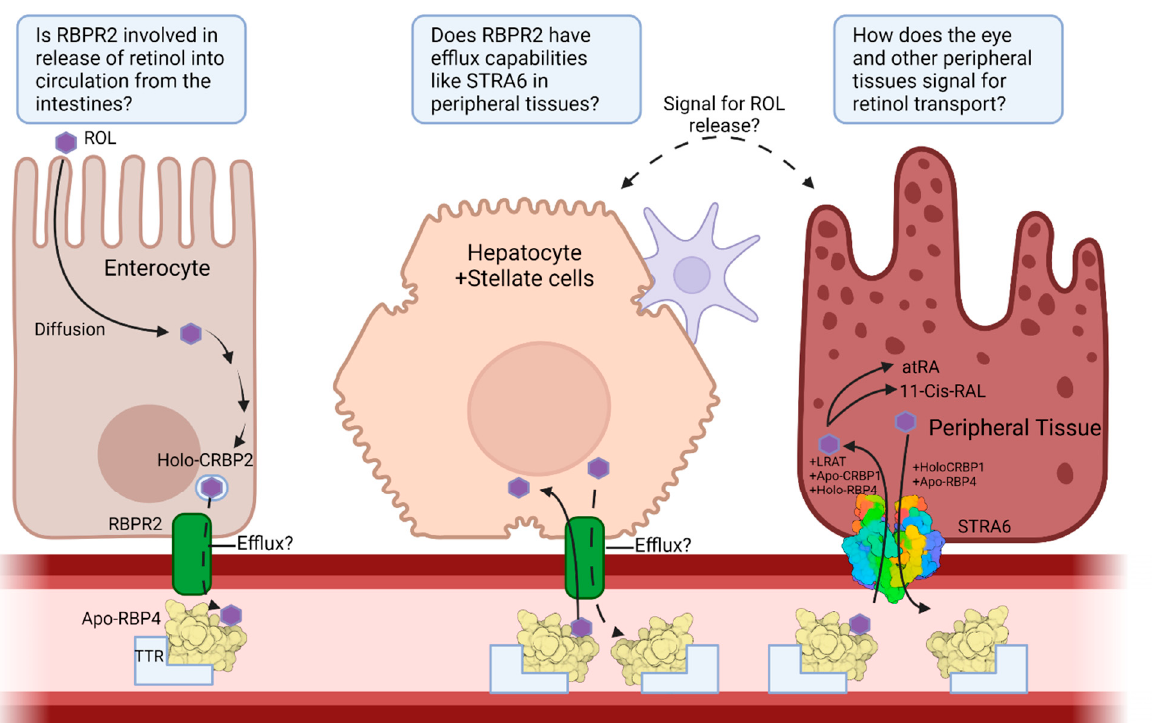
Figure 4. Overview of the transport pathway of vitamin A and the important proteins involved from its entrance through the enterocytes, to its influx and efflux from storage in hepatocytes, and its entrance to peripheral tissues. Questions about RBPR2 function in the intestines, probable efflux capability, and signaling mechanism for vitamin A release into serum are included. ROL—All- trans Retinol; CRBP1—Cellular Retinol Binding Protein 1; CRBP2—Cellular Retinol Binding Protein 2; STRA6—Stimulated by Retinoic Acid 6; RBPR2—Retinol Binding Protein 4 Receptor 2; RBP4—Retinol Binding Protein 4; TTR—Transthyretin; atRA—All- Trans Retinoic Acid; 11-Cis-RAL—11-Cis-Retinal; Apo—Unbound state; Holo—Bound state. Created with BioRender.com.